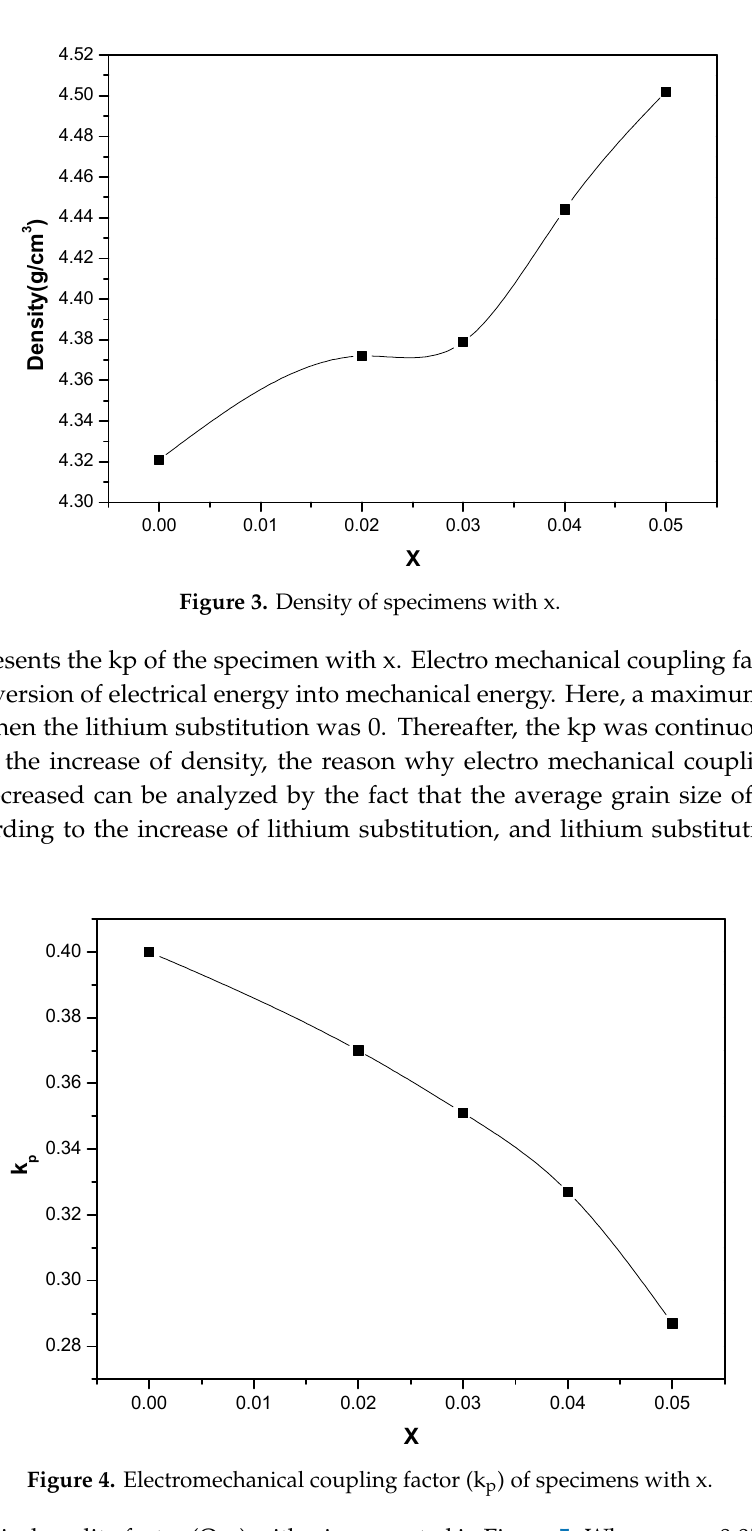
Figure 4. Electromechanical coupling factor (k p ) of specimens with x.